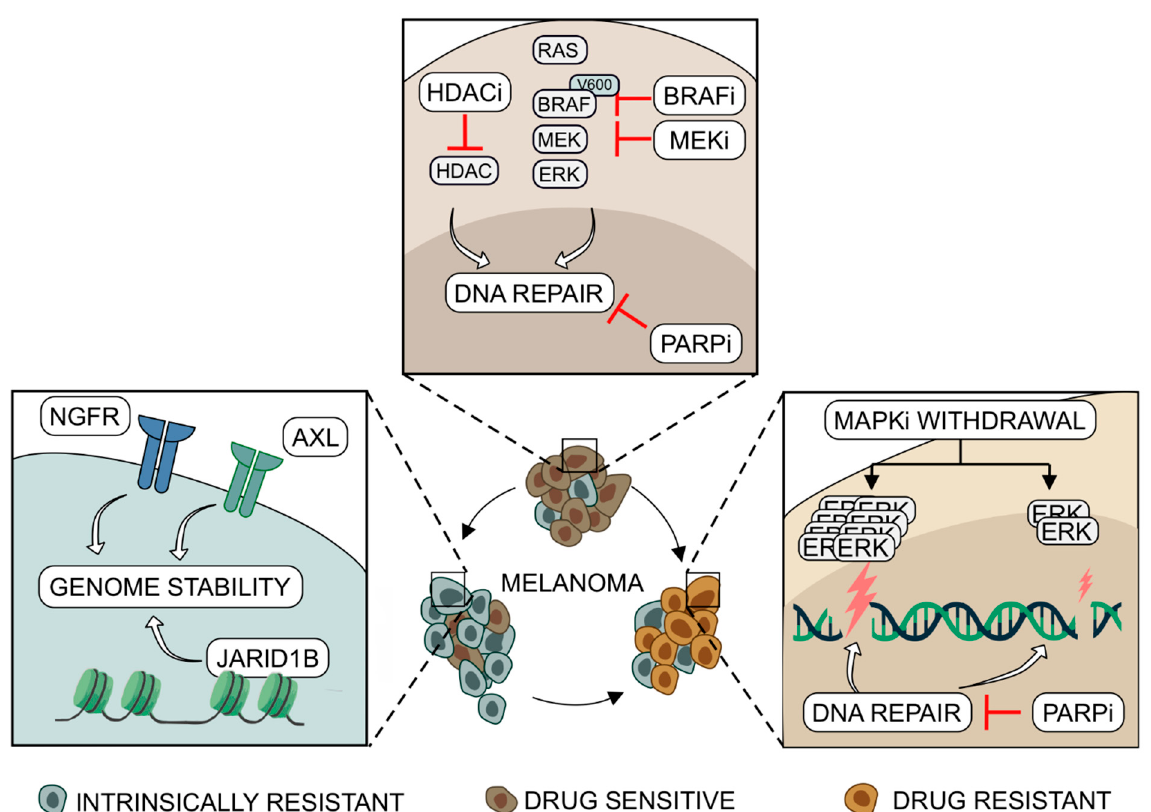
Figure 1. Melanoma cells treated with BRAF and MEK inhibitors depend on efficient DNA repair and genome stability for survival. In drug-naïve melanoma cells, inhibitors of BRAF (BRAFi) and MEK (MEKi) reduce the expression of DNA repair related genes, which can be enhanced by PARP and HDAC inhibitors (PARPi, HDACi) to increase melanoma cell death. Increased expression of NGFR, AXL and JARID1B protects the genome of melanoma cells intrinsically resistant to MAPK inhibitors (MAPKi). Such intrinsically drug-resistant melanoma cells are selected by MAPKi treatment and lead to disease progression. Occurring in parallel, development of acquired drug resistance through reactivation of ERK signaling may result in excessive ERK activity upon immediate drug withdrawal and DNA damage, which can be enhanced by DNA repair inhibitors such as PARP inhibitor (PARPi). Inhibitory effect is marked by red bar-headed arrows.